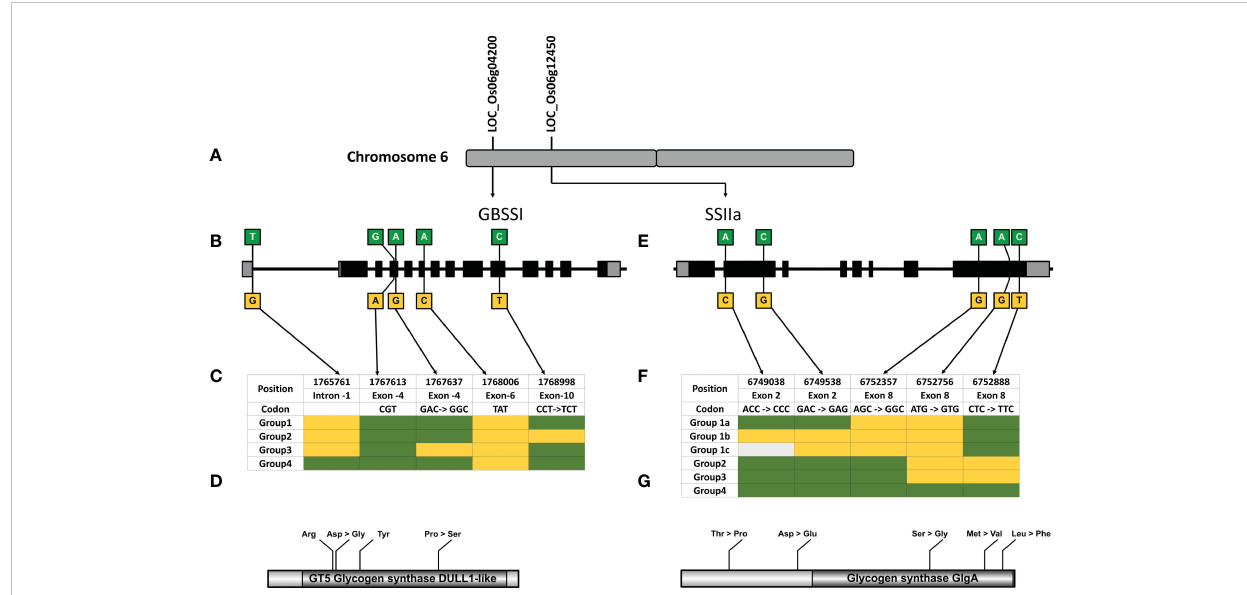
FIGURE 5 Haplotype analysis of Granule Bound Starch Synthase I (GBSSI) and Starch Synthase IIa(SSIIa). (A) The genes coding for GBSSI and SSIIa are located on the short arm of chromosome 6. (B) Gene diagram showing the non-synonymous variations of GBSSI, comprising 13 exons (grey boxes-UTR, Black boxes- CDS). (C) Haplotype table showing the SNP positions within GBSSI, four haplotypes are constructed based on the sequence variations in 25 rice genotypes (green indicates the reference allele Nipponbare, yellow indicates the SNPs and light grey shows missing data). (D) Depiction of GBSSI protein and amino acid changes in the GT-5 Glycogen Synthase DULL like domain predicted using NCBI CDD (E) Gene diagram showing the non-synonymous variations of SSIIagene comprised of 8 exons. (F) Haplotype table showing the SNP positions within SSIIa, four haplotypes, color codes same as (B) . (G) Depiction of SSIIa protein and amino acid changes in the Glycogen Synthase Glga domain predicted using NCBI